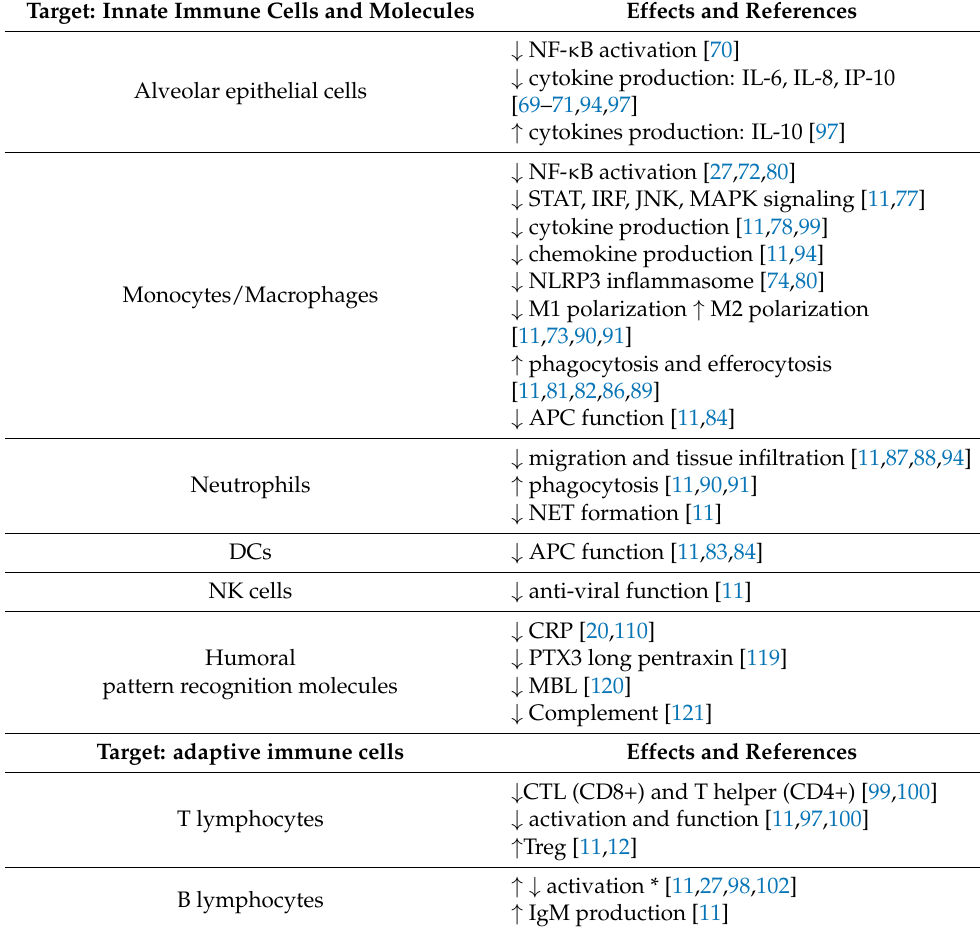
Table 4. PUFAs effects on Immunological Biomarkers associated with COVID-19 related ARDS. Target: Innate Immune Cells and